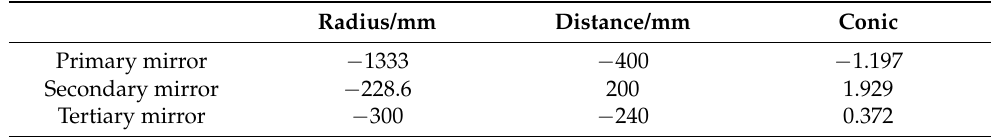
Table 6. Initial structural parameters of